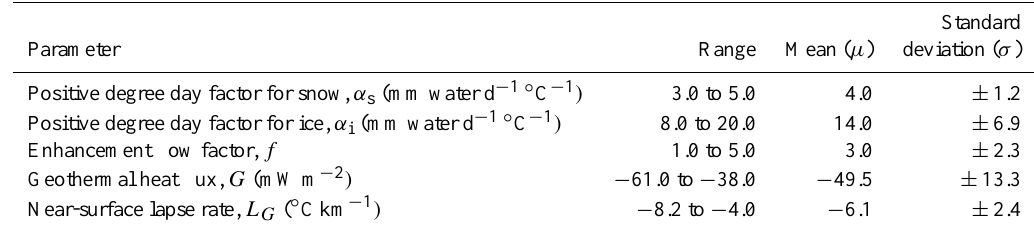
Table 1. List of five parameters varied according to ranges determined in the literature (Stone et al., 2010). Also included are the mean and standard deviation for each parameter used in Eq.